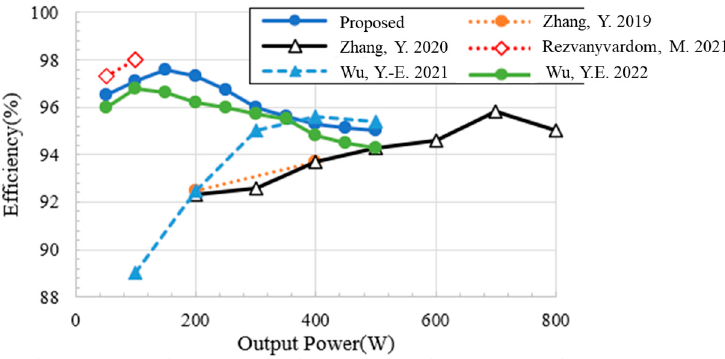
Figure 17. Efficiency of the compared converters in the step-up mode [20,21,24,27,30].